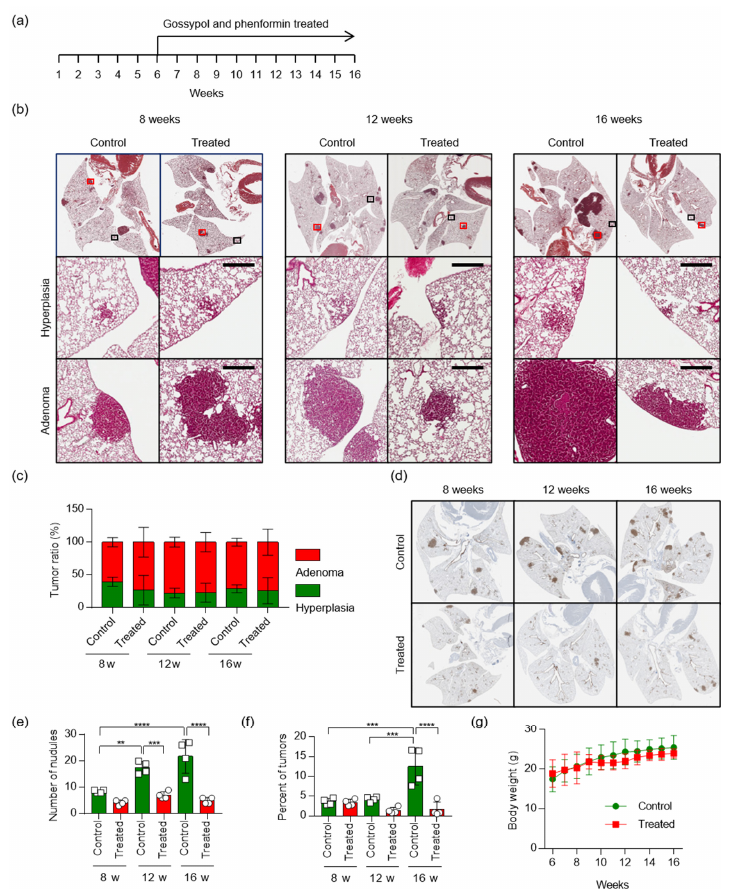
Figure 6. Combined treatment with gossypol and phenformin suppresses KRAS -driven lung tumorigenesis in mice. ( a ) Scheme of the experimental protocol. Kras LA2 mice were divided into two groups: one group was the control, and the other was treated with gossypol (40 mg/kg) and phenformin (100 mg/kg) by oral administration once a day, 5 days a week, for 10 weeks, from 6 to 16 weeks after birth. ( b ) Representative photomicrographs of hematoxylin and eosin (H&E) staining (Top), hyperplasia lesion (Middle, black box) and adenoma lesion (Bottom, red box) in mouse lungs harvested 16 weeks after birth. Scale bar = 400 μ m. ( c ) Lungs of mice were analyzed, and all lesions were classified for hyperplasia and adenoma. ( d ) Representative photomicrographs of cytokeratin 19 staining in mouse lungs, harvested 16 weeks after birth. ( e ) Quantitative analysis of the number of tumor nodules and ( f ) tumor area (expressed as %) in the lung of control ( n = 4) or gossypol/phenformin treated ( n = 4) Kras LA2 mice at 8, 12, and 16 weeks after birth. Tumor burden (expressed as %) was calculated by dividing the total tumor area by the total area of the lung. p -values were obtained by one-way ANOVA test and are indicated by asterisks (** p < 0.01; *** p < 0.001; **** p < 0.0001). ( g ) Body weight was measured once a week ( n =